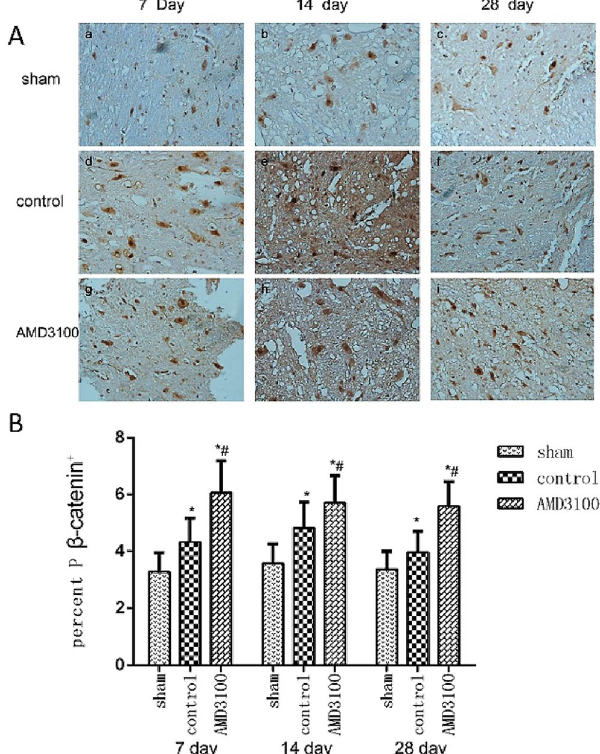
Figure 8. The expression of phosphorylase β -catenin protein in the three groups of rats after surgery. ( A ) Representative images of IHC staining of phosphorylase β -catenin in the three groups ( × 400). It showed that the expression of phosphorylase β -catenin also increased in both of AMD3100 and untreated groups. ( B ) The expression level of phosphorylase β -catenin was significantly higher in AMD3100 group than that in untreated group on the 7th, 14th and 28th day after surgery. ( * P < 0.05: untreated group vs. sham group, AMD3100 group vs. sham group; # P < 0.05: AMD3100 group vs. untreated group).